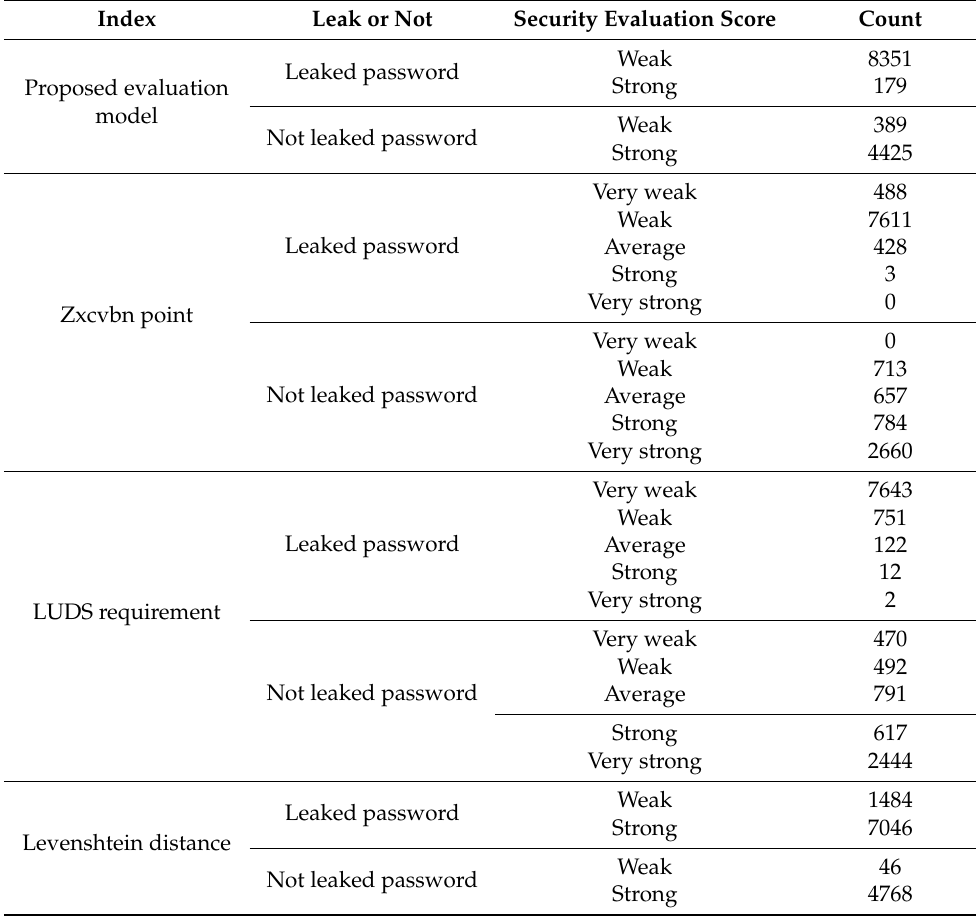
Table 7. Comparison for password security evaluation